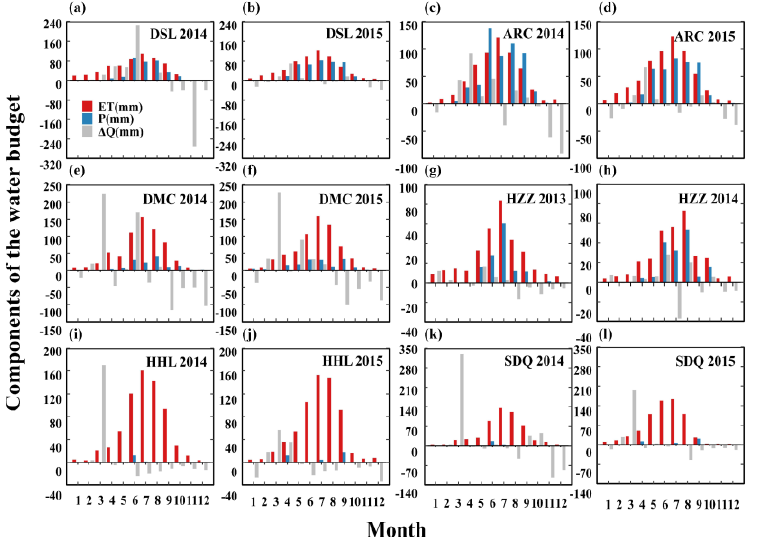
Figure 3. Monthly variation of observed water budget components (precipitation, ET and change of soil water storage) of two years in ( a , b ) alpine swamp meadow (DSL) in 2014–2015 year; ( c , d ) alpine meadow (ARC) in 2014–2015 year; ( e , f ) cropland (DMC) in 2014–2015 year; ( g , h ) Kalidium foliatum (HZZ) in 2013-2014 years, ( i , j ) T.ramosissima (SDQ) in 2014-2015 year; ( k , l ) P.euphratica in 2014-2015 year.